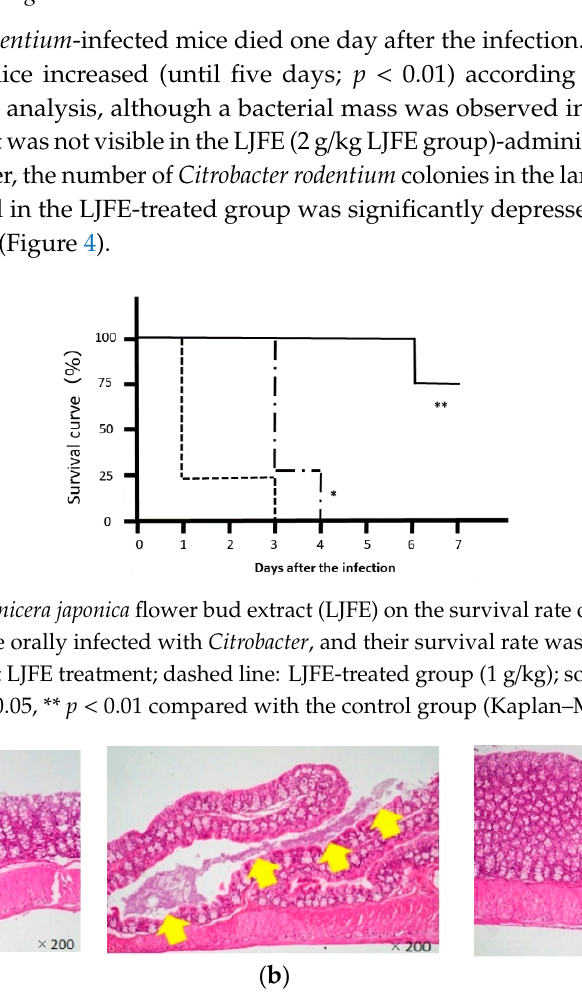
Figure 1. Three-dimensional high-performance liquid chromatogram of Lonicera japonica flower bud extract (LJFE).